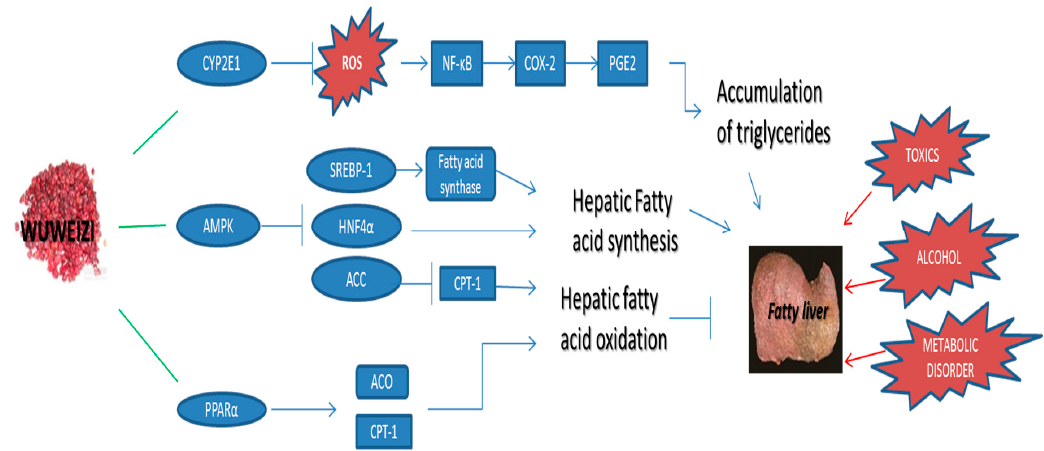
Figure 2. Schematic illustrating proposed potential hepatoprotective mechanisms of Wuweizi.